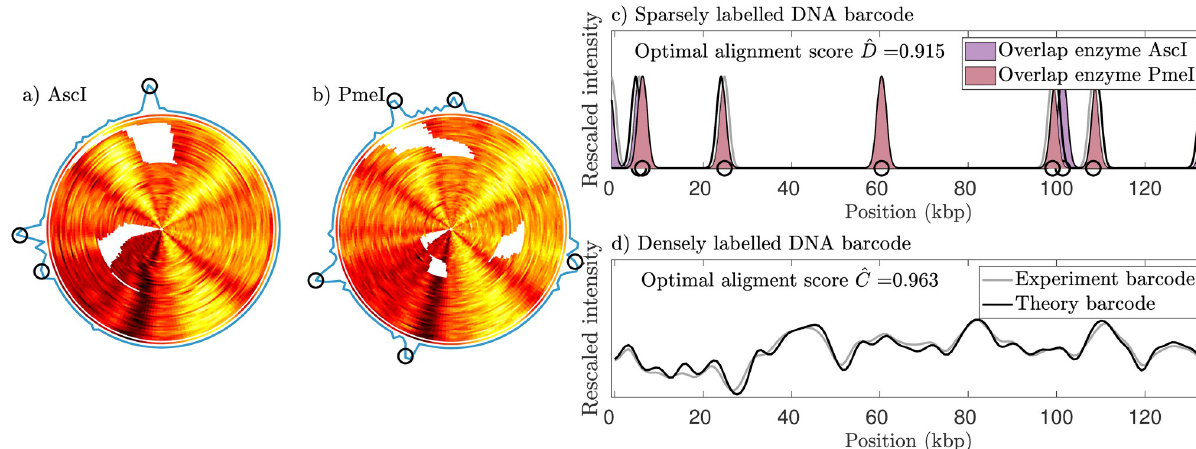
Fig 4. Experimental dually-labeled barcodes for the 130 kbps plasmid. The 130 kbps plasmids were digested sub-optimally (one cut per molecule) using two different enzymes [(a) AscI and (b) PmeI]. DNA barcodes for these digested plasmids were obtained through dense labeling (competitive binding assay). The experimental competitive binding barcodes were aligned into a consensus barcode as illustrated in the concentric plots above. The locations of cuts for each barcode are shown as the white regions. The determined locations of significant clusters of cuts (see Methods) are shown by the black circles (the sparse labels). The enzyme AscI produced three cuts while the enzyme PmeI produced five cuts. (c) Two theoretical cut-labeled barcodes have been aligned to the corresponding experimental cut-labeled barcodes in the orientation and circular shift where the alignment score, Eq (2), is maximized. The regions of overlap between experimental and theoretical barcodes corresponding to the same enzyme have been highlighted. (d) Densely labeled experimental consensus barcode aligned to the corresponding theoretical barcode. The alignment is at the orientation and circular shift where its alignment score, Eq (3), is maximized. The intensity values have been re-scaled such that the intensity values of each barcode have the same mean and standard deviation as the other.